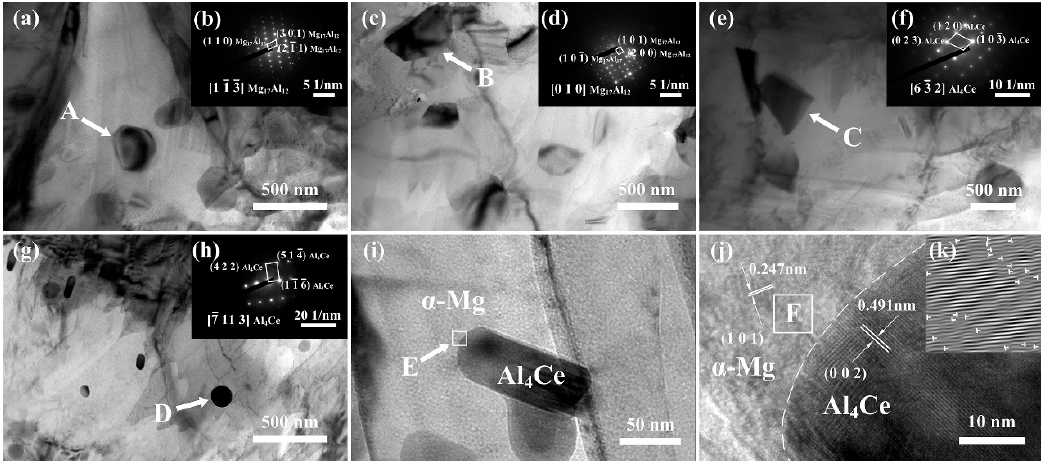
Figure 7. ( a, c, e, g, i ) Bright-field transmission electron microscope (TEM) micrographs of the as-extruded AZ80-0.8Ce alloy; ( b, d, f, h ) corresponding diffraction patterns of selected particles taken from the ( a, c, e, g ), indicated by arrows of A, B, C and D, respectively; ( j ) high-resolution TEM (HRTEM) image of the zone E in ( i ); ( k ) inverse fast-Fourier-transform (IFFT) image of the zone F in ( j ) (remark: the “T” shaped symbols represent for the dislocations).